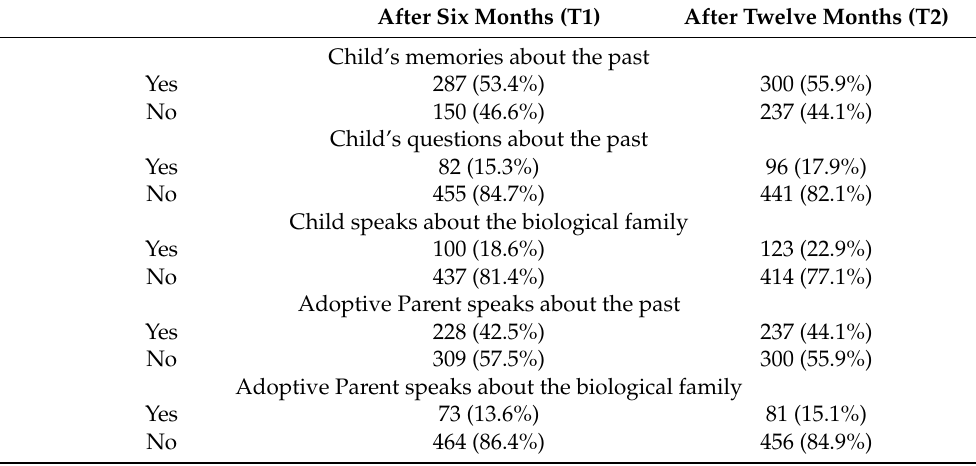
Table 2. Adoption-related issue communication dimensions in both children and parents.